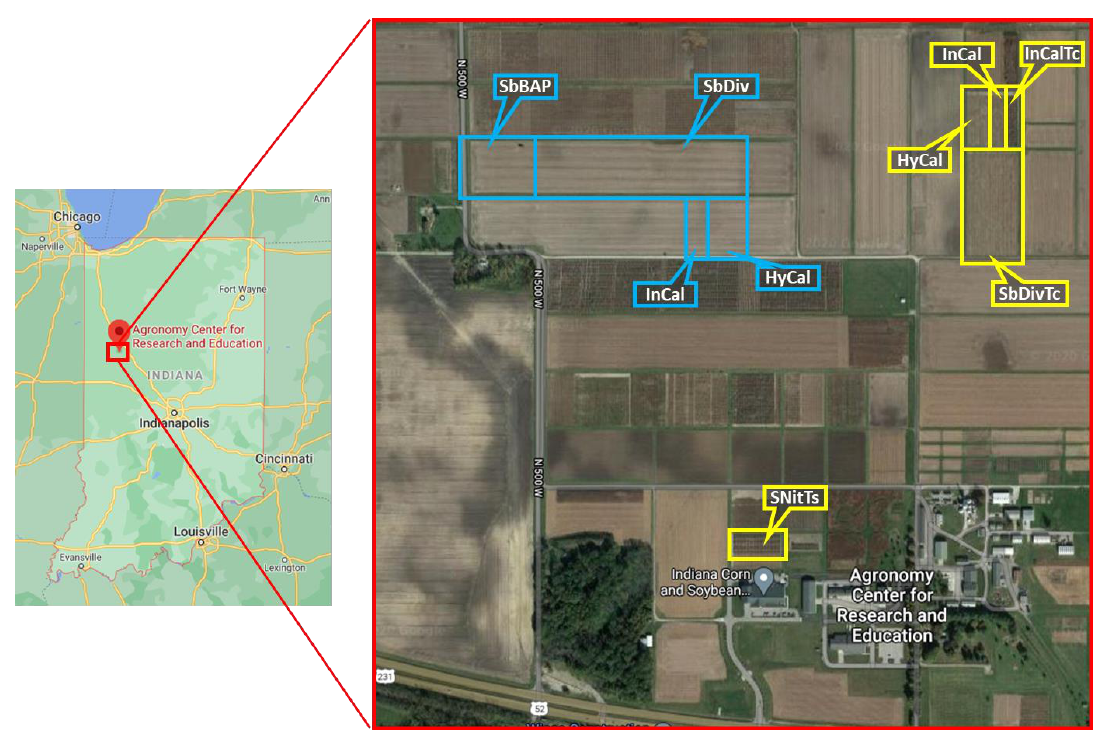
Figure 1. Experimental site: the field trials at Agronomy Center for Research and Education (ACRE) are highlighted by blue (the 2017 fields) and yellow (the 2018 fields).